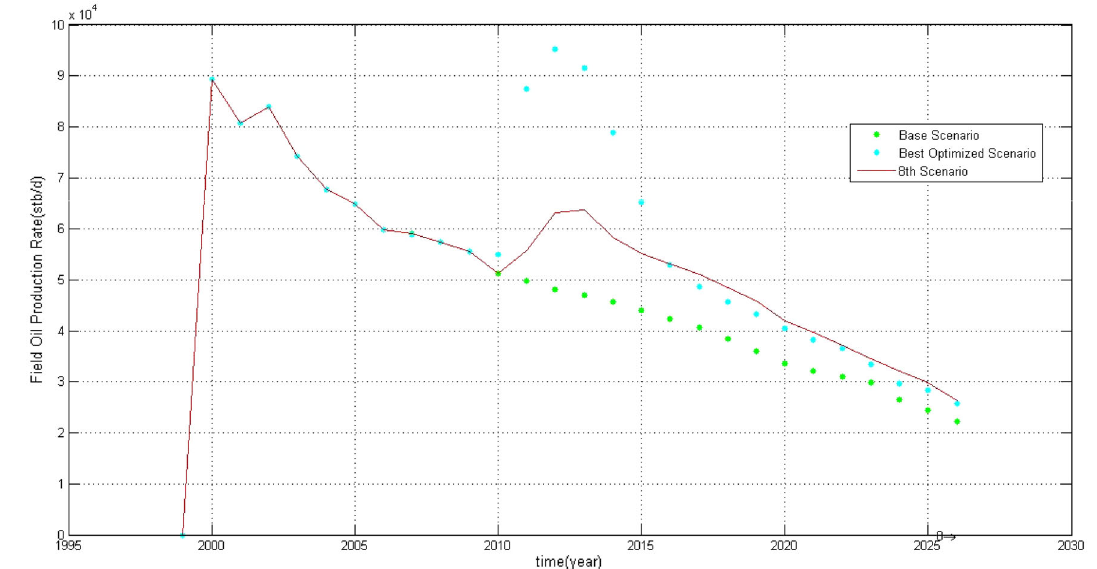
Fig. 17 Field production rate of eighth scenario Table 2 Production statistics at the end of prediction period (2026) for scenarios 8–8e